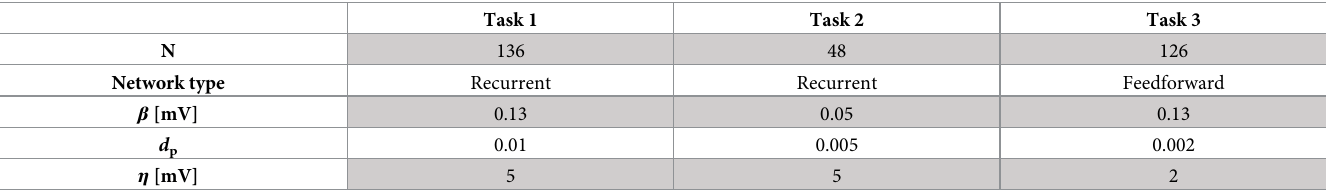
Table 1. The task-dependent variables are